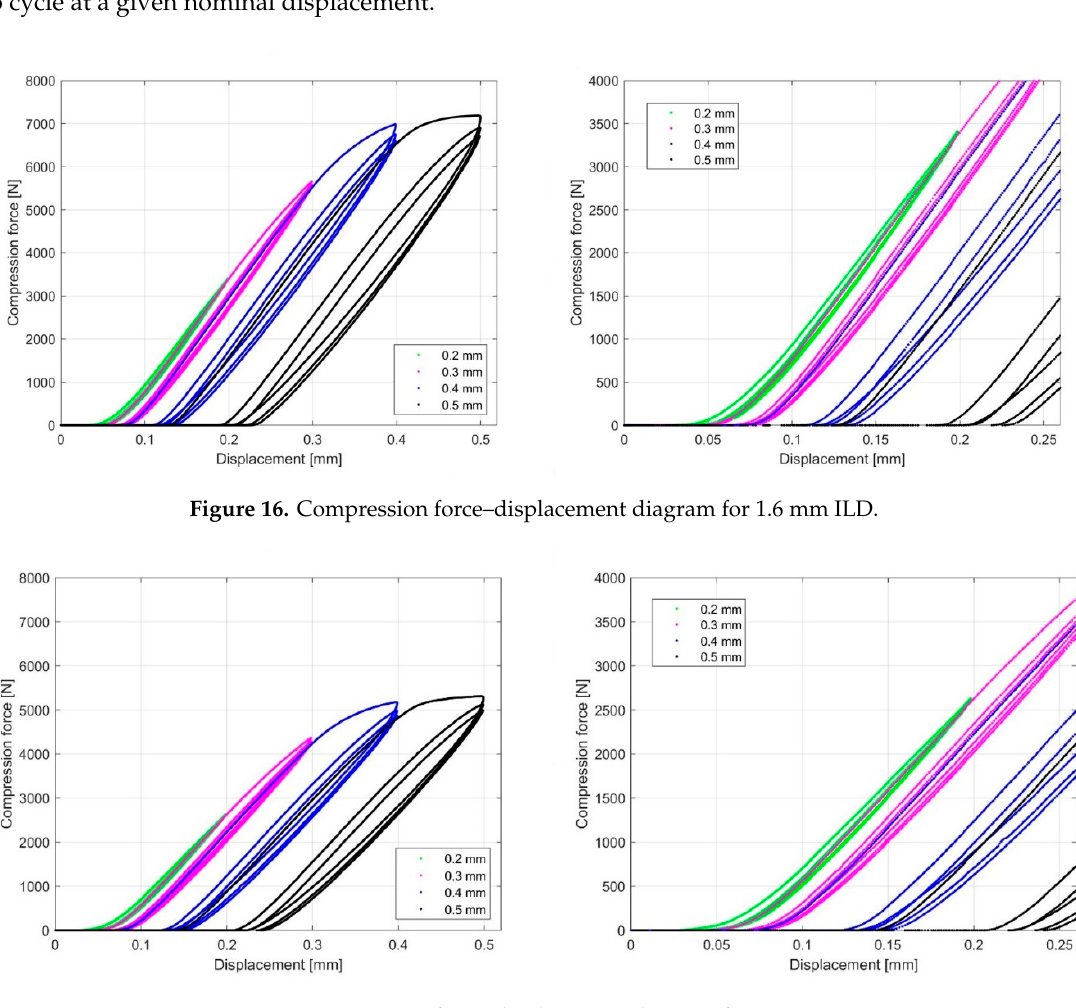
Figure 17. Compression force–displacement diagram for 2.4 mm ILD.